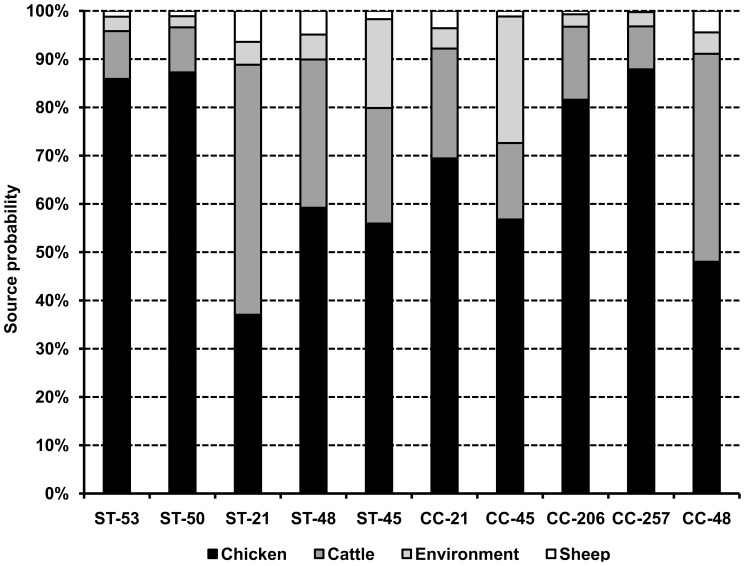
Attributed probability (%) for the five most represented sequence types and clonal complexes to originate from chicken, cattle, sheep, and the environment.The probability for pigs is not viewable because it is <1%.